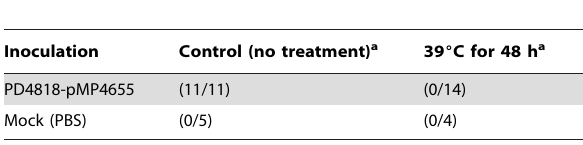
Table 2. Effect of heat-treatment on recovery of bacteria from lesions in inoculated A. hippocastanum